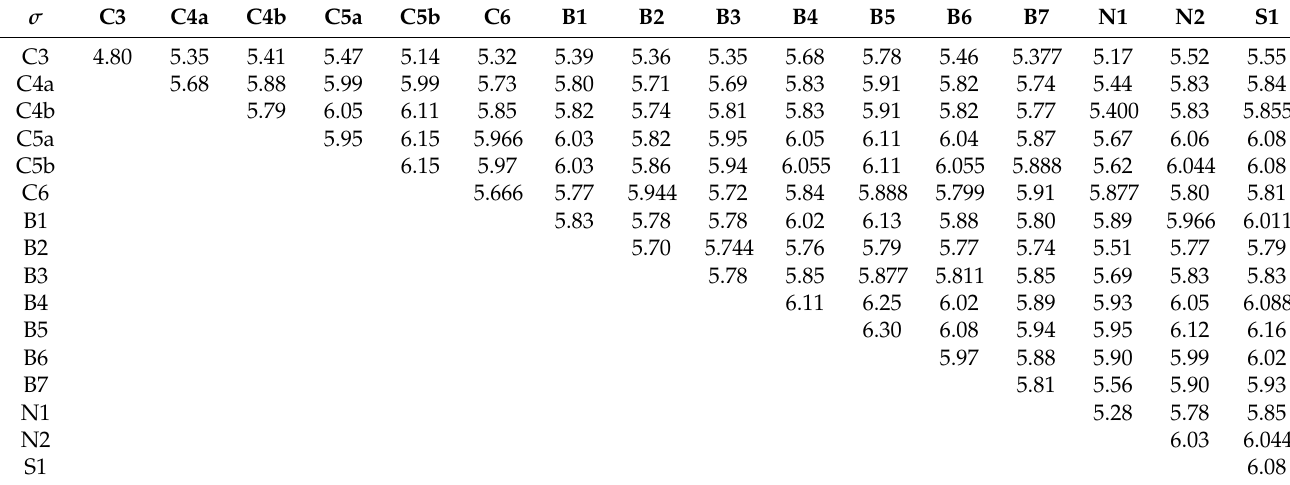
Table 5. Force field parameter σ .